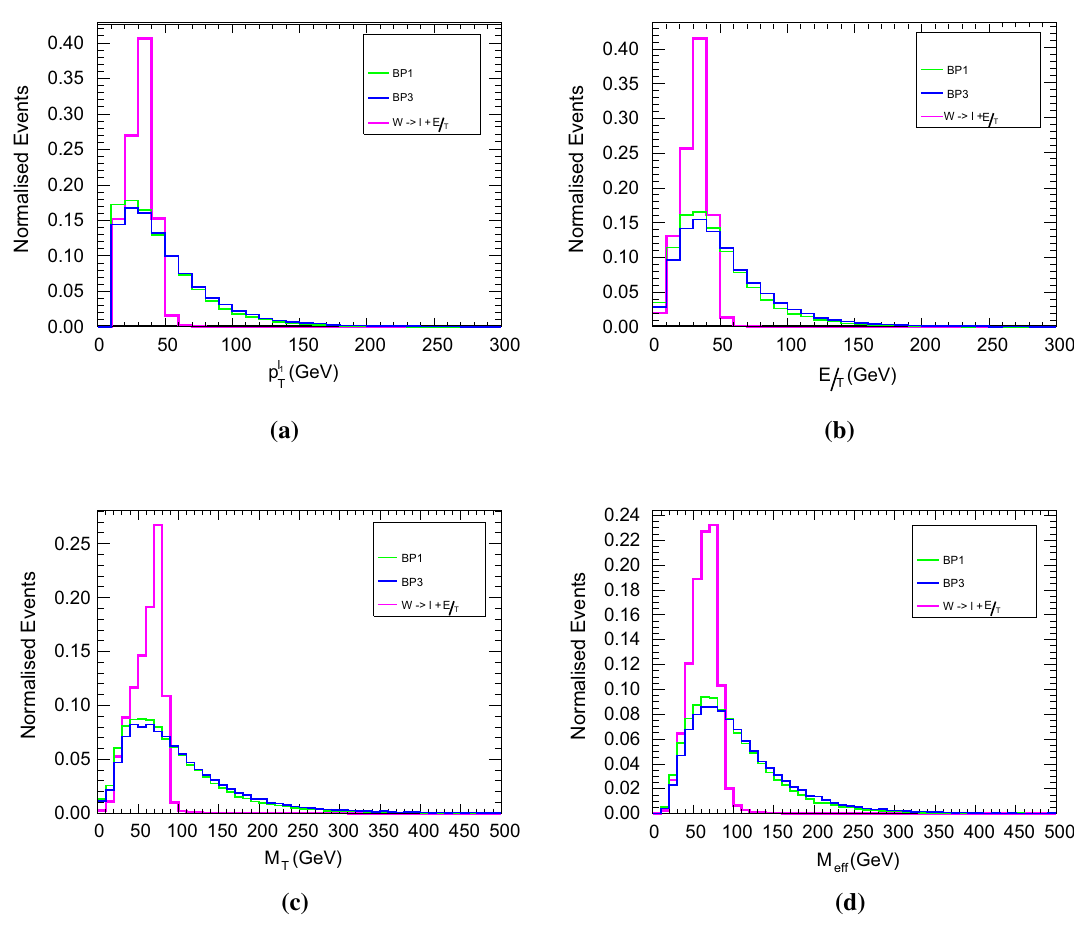
Fig. 4 Normalised distributions of ( a ) p (cid:3) 1